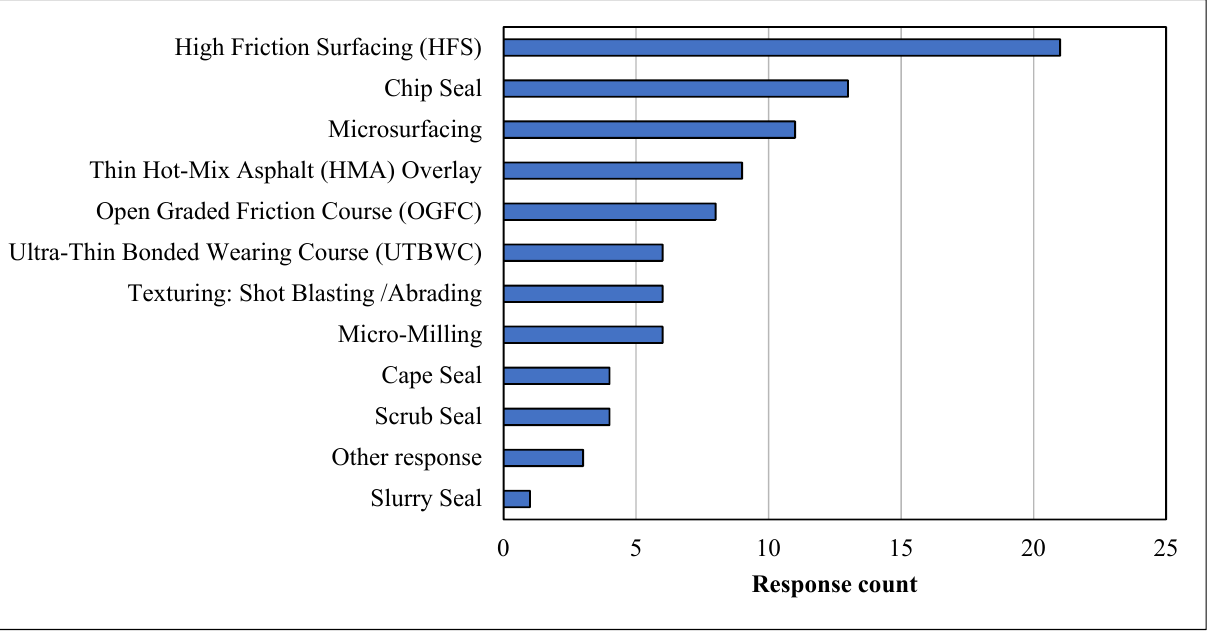
Figure 7. Types of pavement friction treatments considered for asphalt pavement.